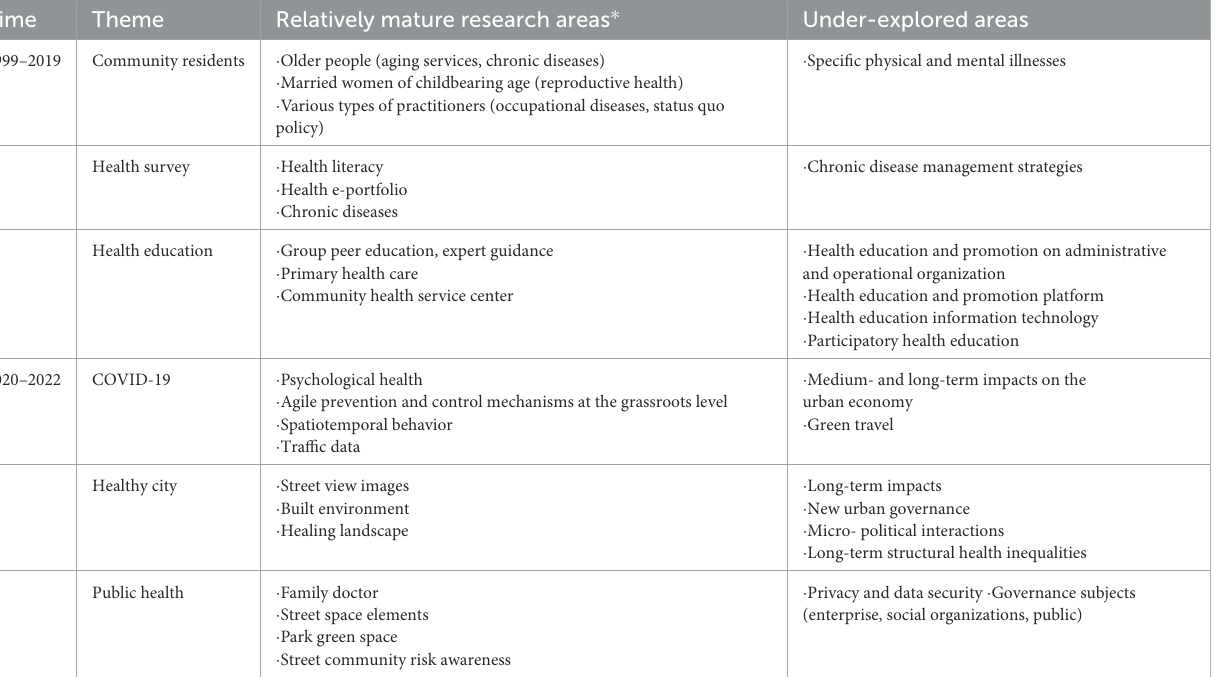
TABLE 1 The list of the relatively mature research areas and under-explored areas.